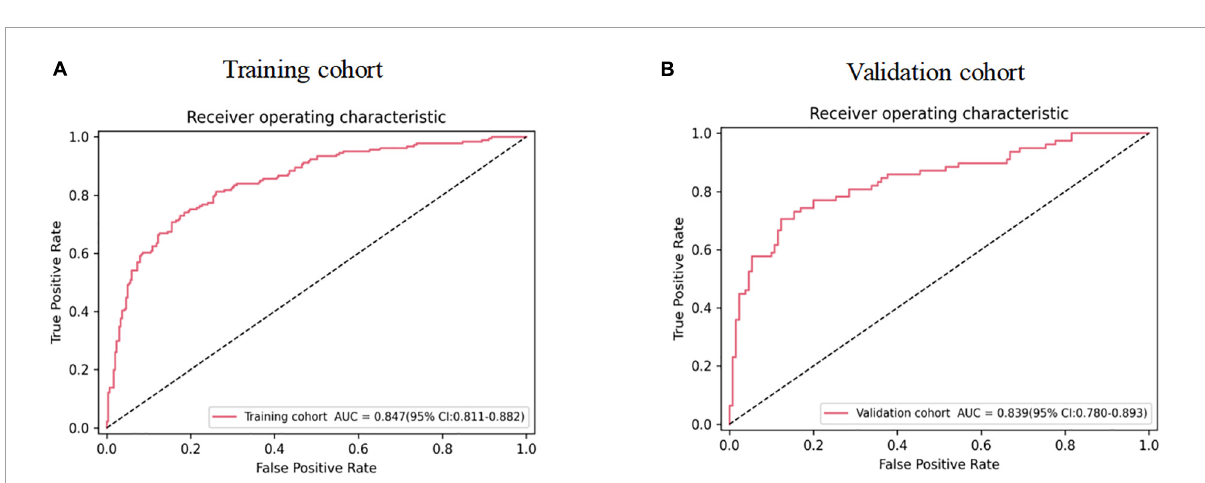
FIGURE2 The ROC of nomogram in panels (A,B) training and validation cohorts. ROC, receiver operating characteristic curve.